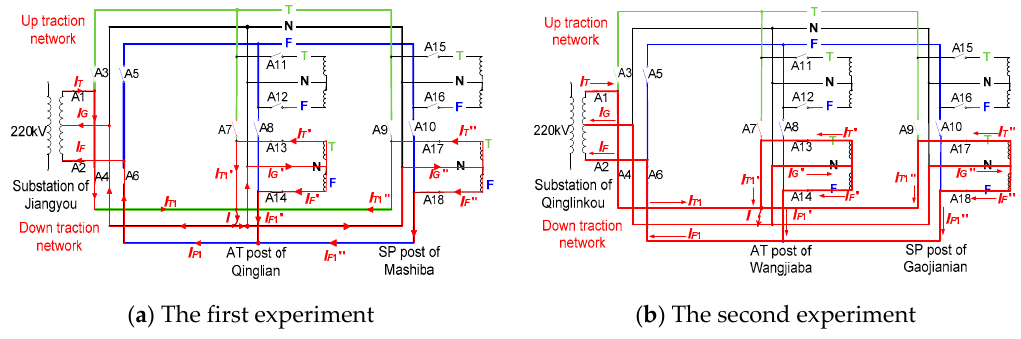
Figure 6. Circuit diagrams of the two short-circuit experiments.